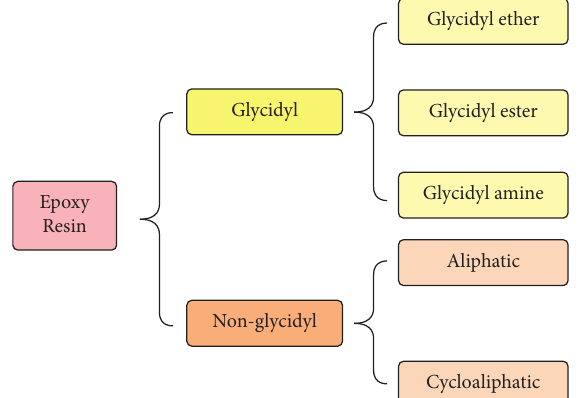
Figure 2: Classification of ER [10].